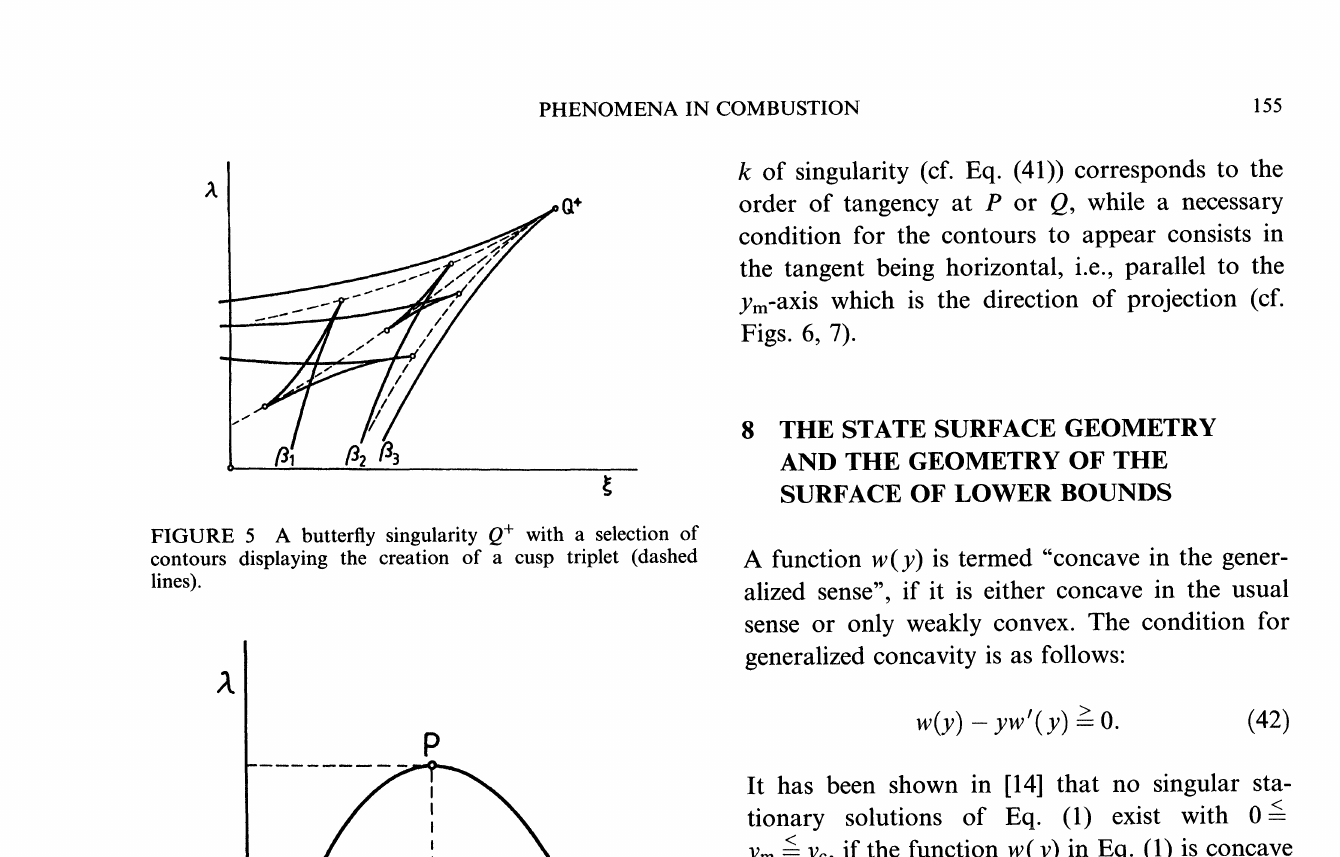
FIGURE 6 A bifurcation diagram with turning point P.